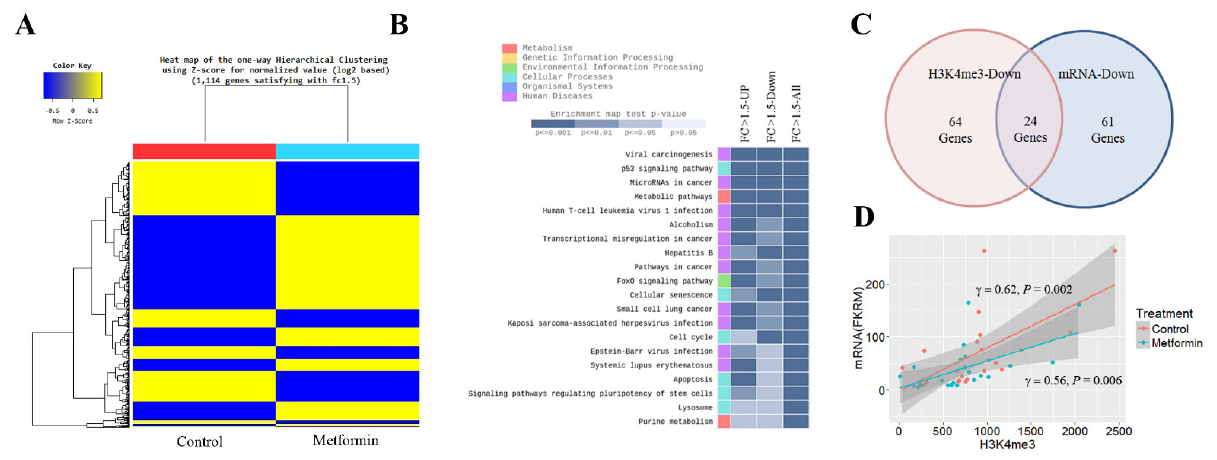
Figure 2. Effects of metformin on mRNA expression. The mRNA levels in H1299 cells treated with 5 mM metformin or left untreated as controls were analyzed by RNA-seq. ( A ) Heatmap shows one-way hierarchical clustering to stratify differentially expressed genes in treated and untreated cells. ( B ) Genes significantly up- or downregulated in response to metformin were identified using the cutoff value |FC| ≥ 1.5. The top 20 KEGG (Kyoto Encyclopedia of Genes and Genomes) pathway terms for genes with more than a 1.5-fold change in their mRNA levels are shown. ( C ) The number of cell cycle genes with reduced H3K4me3 at the promoter regions or downregulated mRNA in cells treated with metformin is shown. ( D ) The correlation between H3K4me3 and mRNA levels was analyzed for twenty-four genes with reduced H3K4me3 and mRNA.